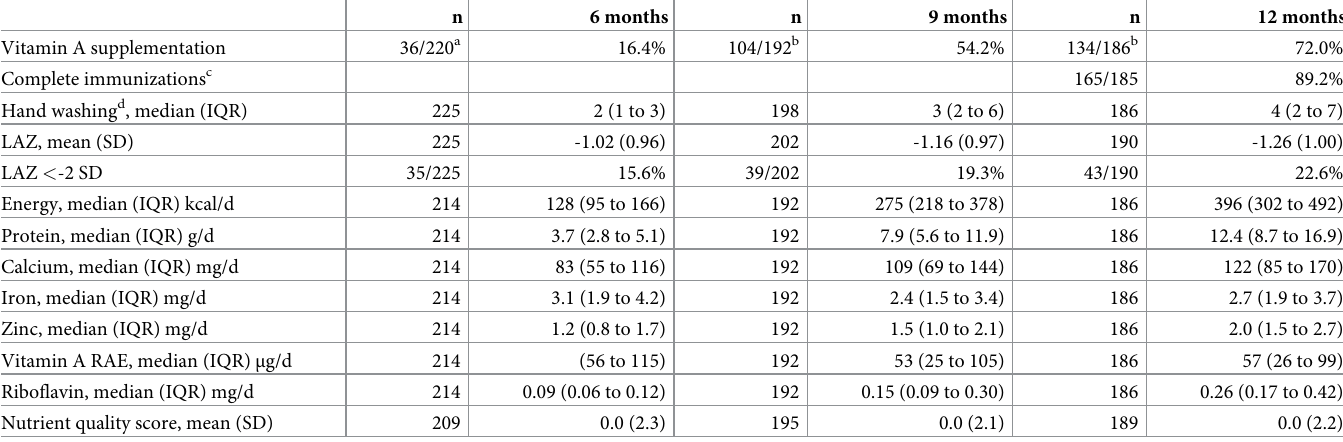
Table 2. Health, anthropometric characteristics, and nutrient intakes at age 6, 9, and 12 months.